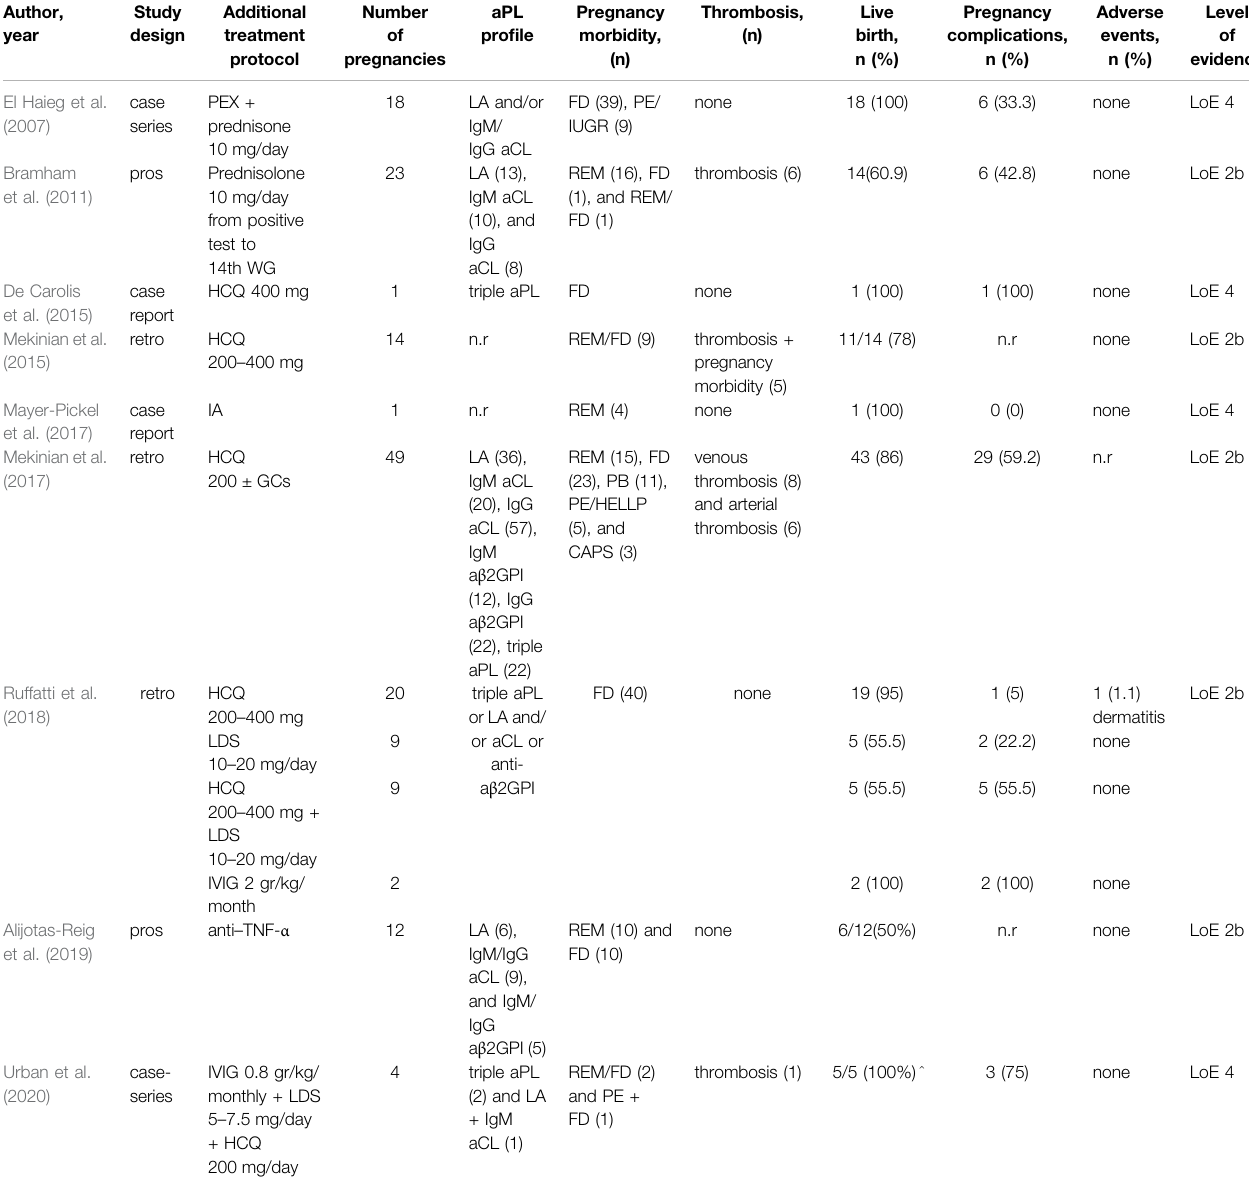
TABLE 1 | Studies investigating the effects of additional therapies in refractory antiphospholipid syndrome (APS)